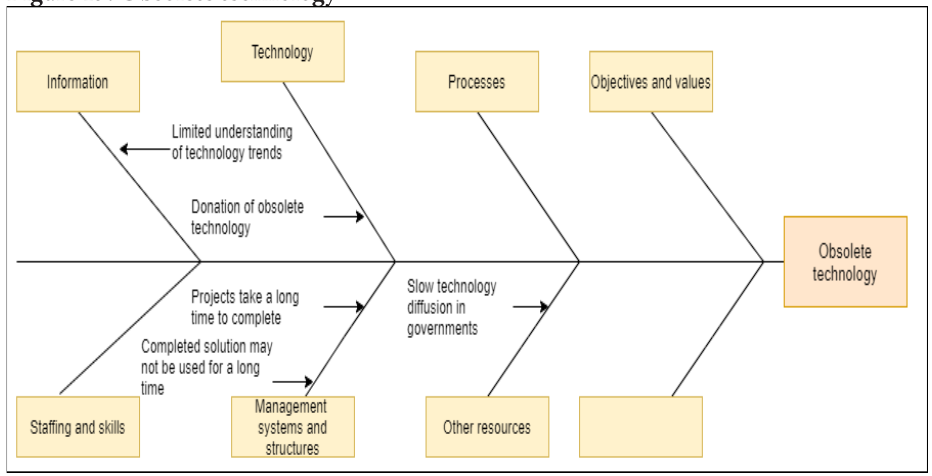
Figure 15: Obsolete